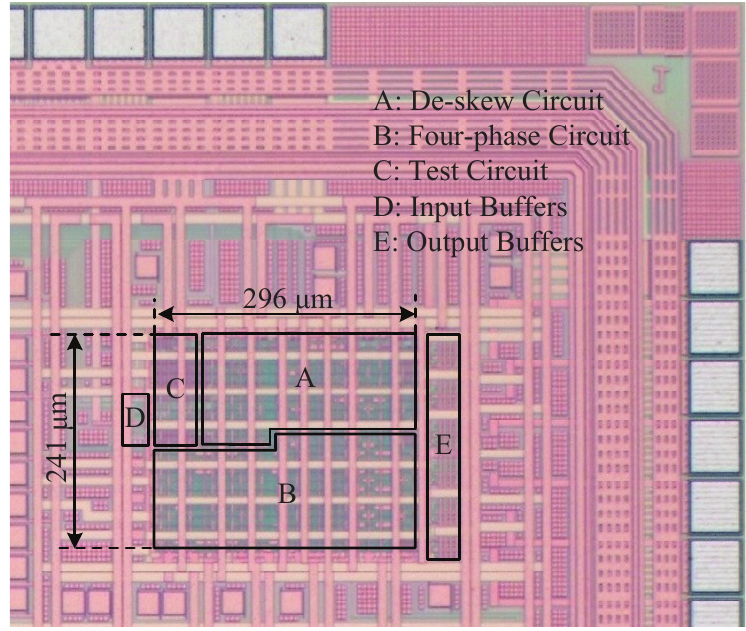
Figure 12. The test chip